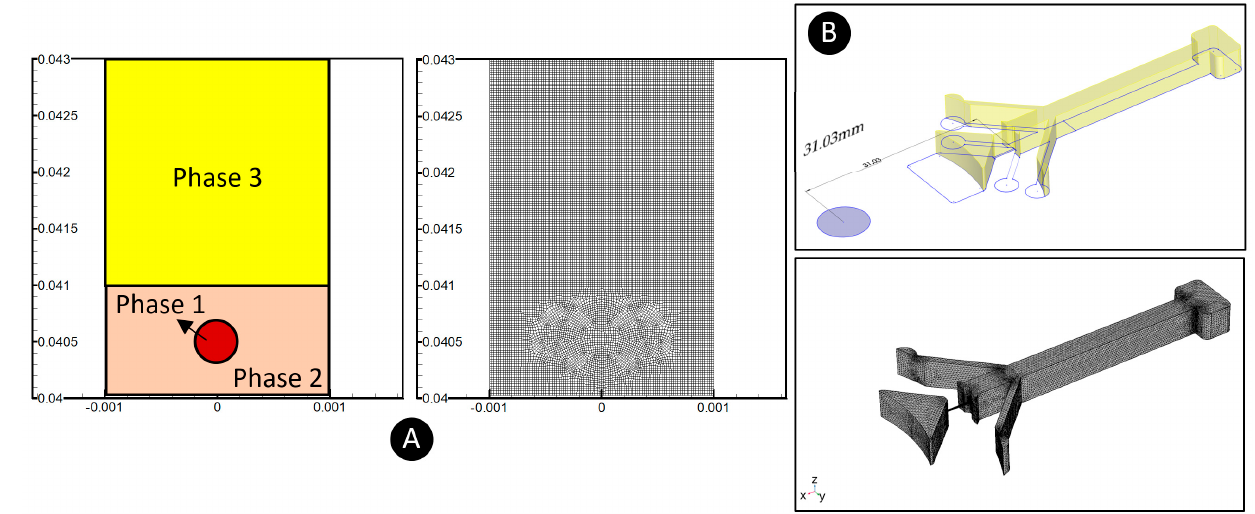
Figure 3. ( A ) The geometry and grids used for the three-phase modeling. The red circle shows the droplet in the water phase (phase 1), the orange medium shows the oil phase fluidic barrier (phase 2), and the yellow rectangle shows the other water phase (phase 3). ( B ) The geometry and grids used for the particle tracing model.